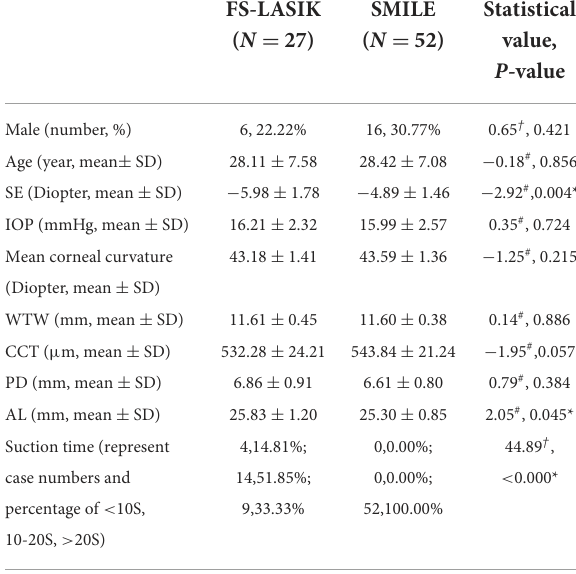
TABLE 1 Comparison of baseline parameters of patients in FS-LASIK and SMILE.